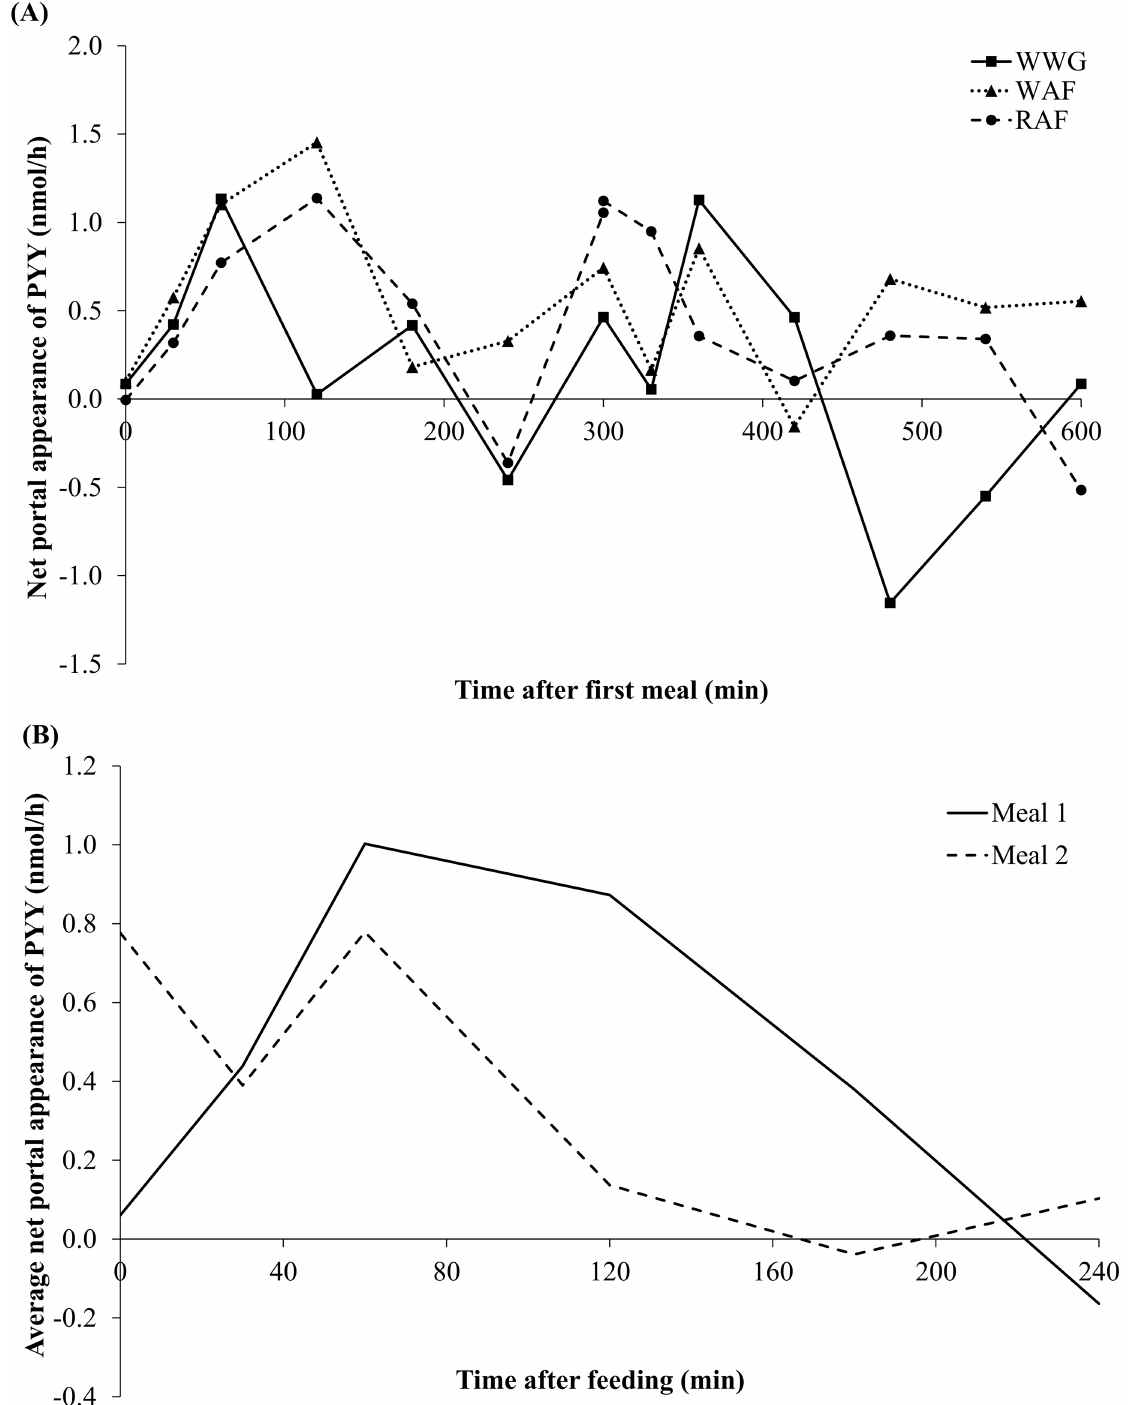
Fig 2. Net portal appearance of PYY following the first (0 min) and second (300 min) daily meals in pigs fed WWG, WAF, and RAF. (A) Net portal appearance of PYY after the first (0 min) and second (300 min) daily meal ( P Diet = 0.21, P Meal = 0.33, P Time = 0.11, P Meal × Time = 0.87, P Diet × Meal = 0.96, P Diet × Time = 0.87, P Diet × Time × Meal = 0.34). Valuesare means, n = 6. The solid lines represent means from pigs fed the whole-wheat grain diet (WWG); dotted lines represent means from pigs fed the wheat aleurone flour diet (WAF); dashedlines representmeans from pigs fed the rye aleuroneflour diet (RAF). (B) Average net portal appearance of PYY for the three experimental diets followingthe first (solid line) and second daily meal (dashedline).